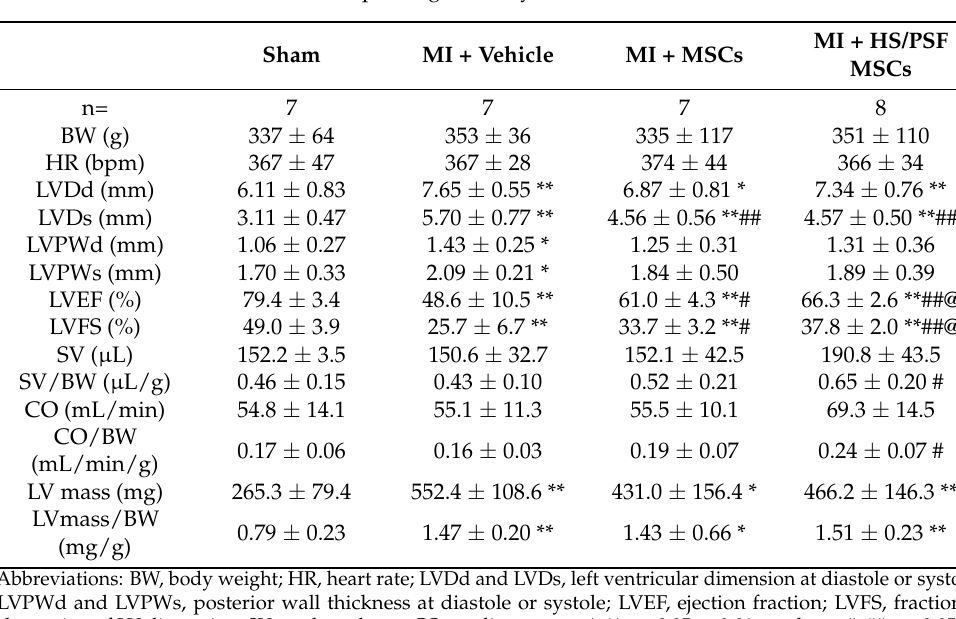
Table 1. Echocardiographic measurements demonstrated that HS/PSF-treated MSCs were more effective than untreated MSCs for improving recovery after infarction. MI + HS/PSF Sham MI + Vehicle MI + MSCs MSCs n= 7 7 7 8 BW (g) 337 ± 64 353 ± 36 335 ± 117 351 ± 110